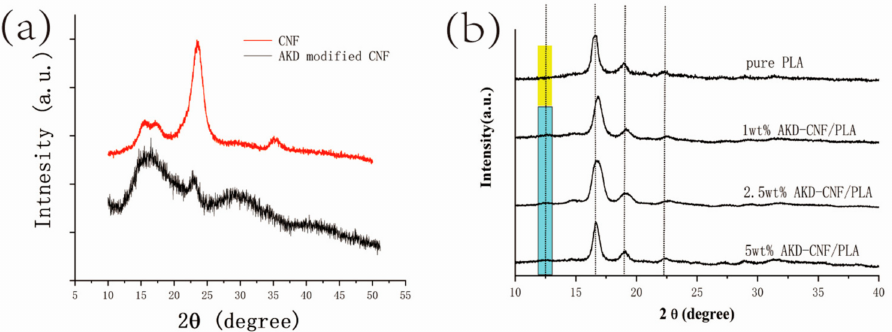
Figure 2. XRD patterns of ( a ) CNF (top) and AKD modified CNF (bottom); ( b ) AKD-CNF/ PLA composites.